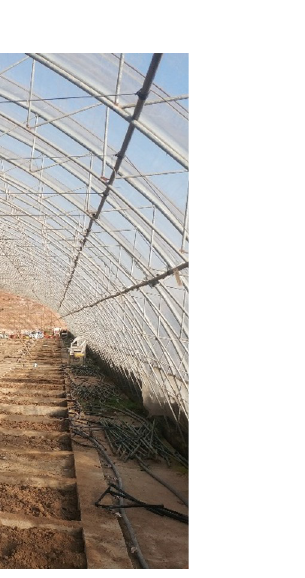
Fig 1. Structure of the experimental Chinese solar greenhouse schematic diagram.